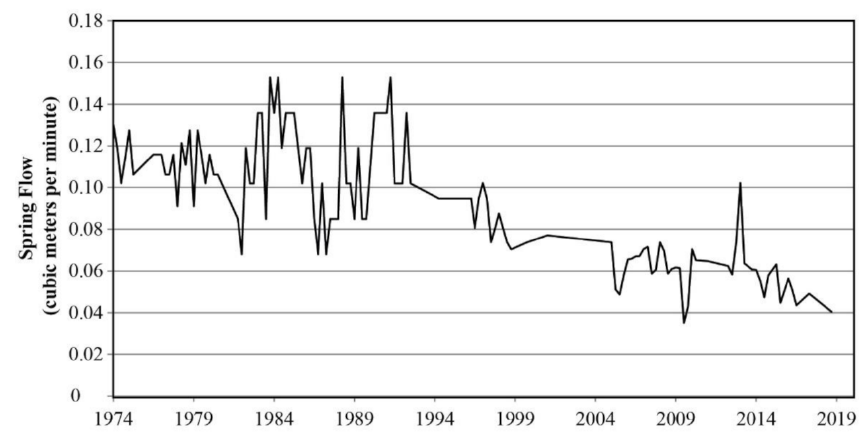
Figure 3. Discharge in cubic meters per minute at Quitobaquito from 1973 to 2017